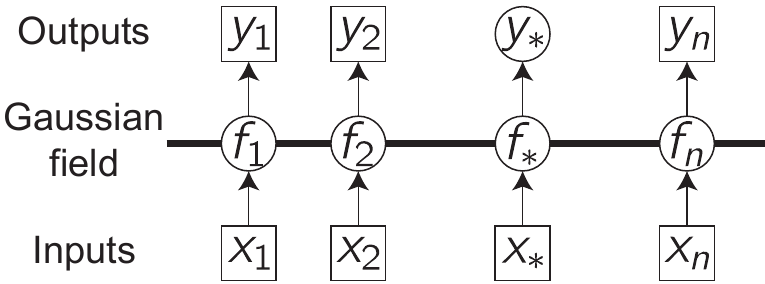
Figure 9. Graphical representation of Gaussian process regression. Squares and circles represent observed variables and unknown variables, respectively. The horizontal bar is a set of fully connected nodes. Each y i is conditionally independent given f i